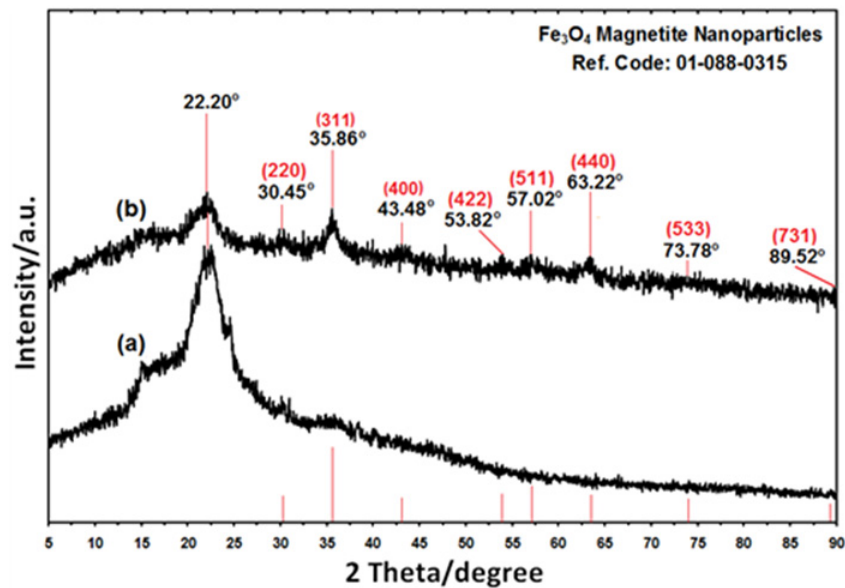
Fig 2. The PXRD of rice straw and rice straw/Fe 3 O 4 -NCs with the related peaks respectively